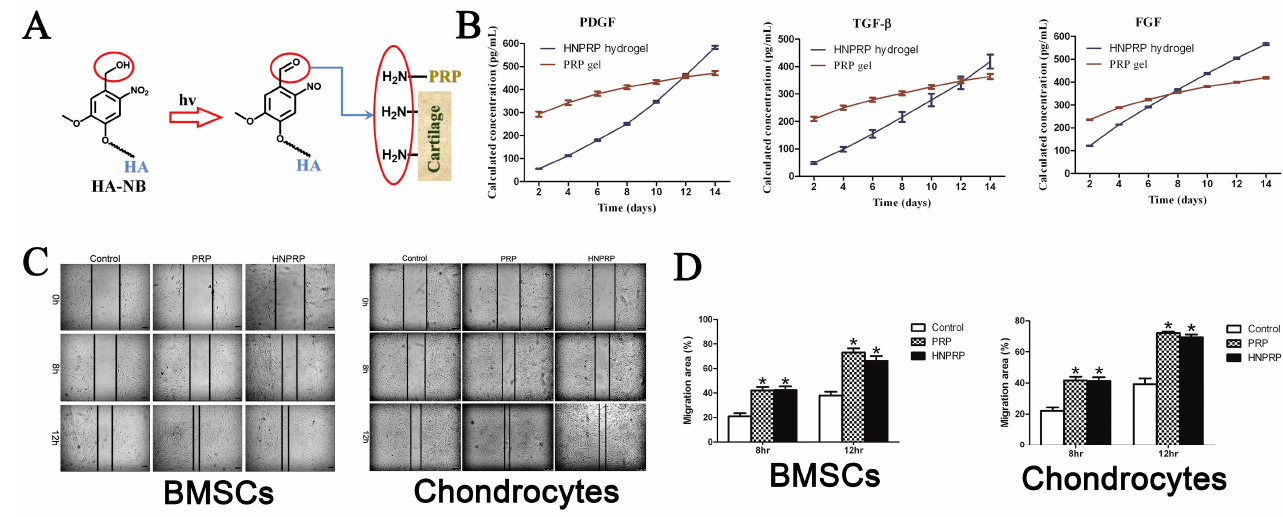
Figure 8. ( A ) Synthesis process of HNPRP hydrogel. ( B ) Release kinetic curves of growth factors (n = 3) released from HNPRP hydrogel or thrombin-activated PRP gel. ( C ) Images of BMSCs and chondrocytes migrating to the scratch area under the presence of HNPRP hydrogel or thrombin-activated PRP gel. ( D ) Statistical data of migration area for BMSCs and chondrocytes ( * p < 0.05 compared with control group). Reprinted with permission from [95].